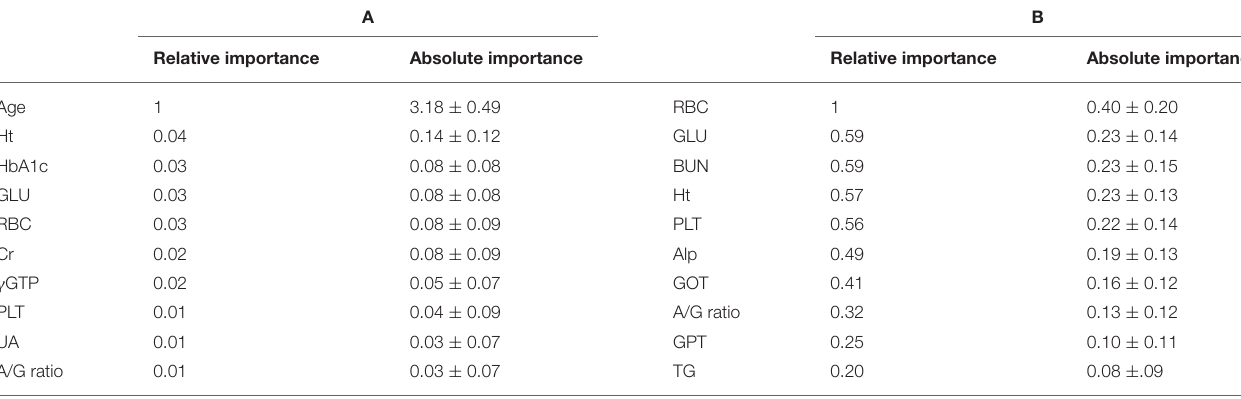
TABLE 4 | Variable importance in the DNN estimation for estimation of GM-BHQ with (A) and without (B) subject’s age. A B Relative importance Absolute importance Relative